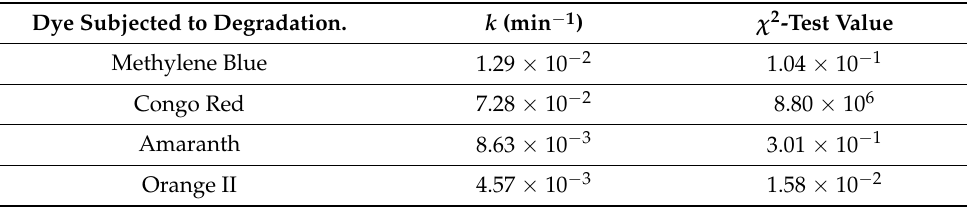
Table 4. Kinetic parameters for photodegradation of different dyes under the fluorescent bulb light in the presence of 0.1% Ag–TiO 2 nanostructured nanofibers photocatalyst (TAg1). Dye Subjected to